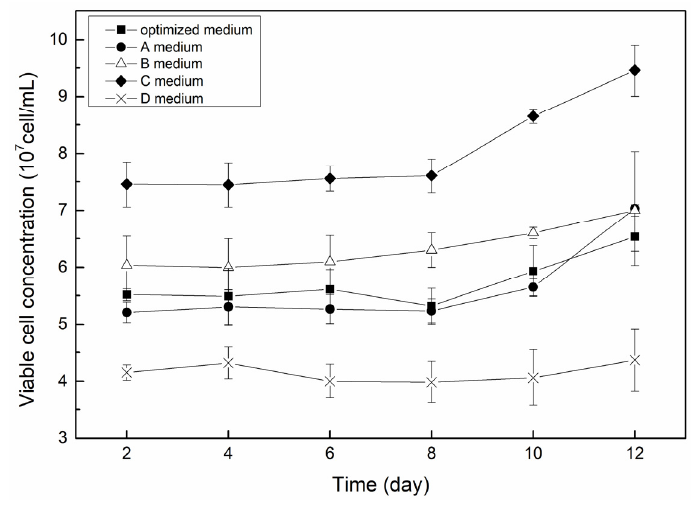
Figure 3. Viable cell concentrations in the effluent for various media.